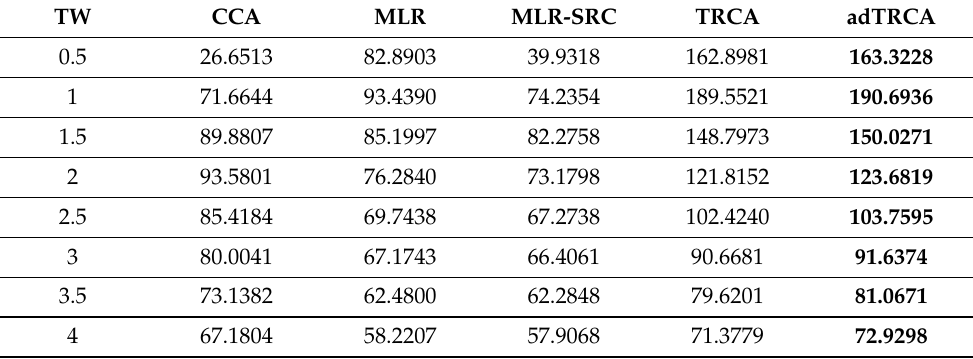
Figure 2. Average Classification over all subjects ( a ) for the Speller dataset and ( b ) for the EPOC dataset using the EEG channels covering the occipital areas. In both cases, the time window ranges from 0.5 s to 4 s (0.5 s interval). * indicates statistically significant difference between the TRCA and adTRCA methods, using paired sample t -test for the Speller dataset and Wilcoxon signed rank test for the EPOC dataset ( p < 0.05). Table 4. ITR on Speller dataset—3